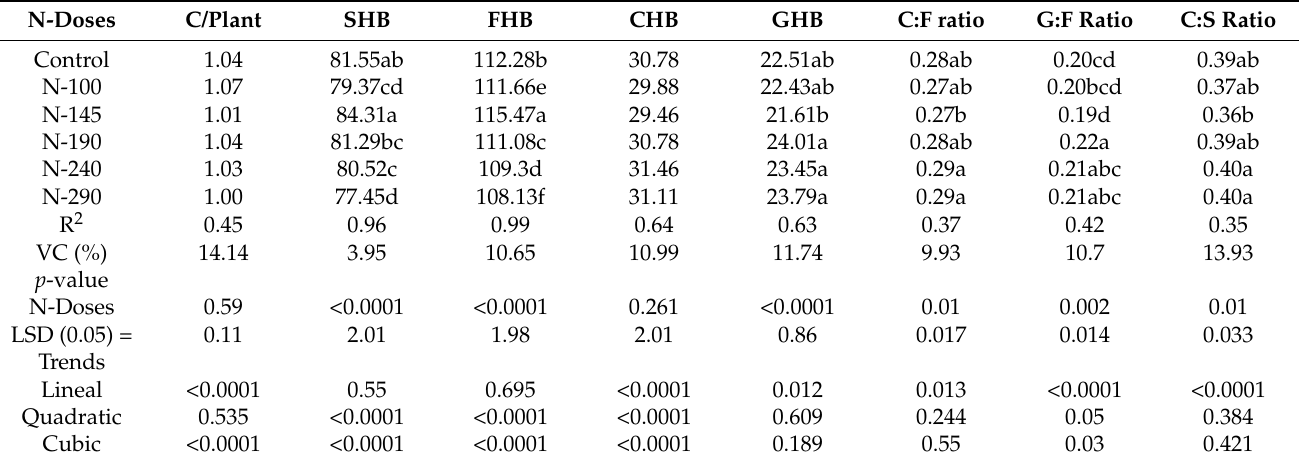
Table 3. Whole plant, cobs, and grain humid base (HB) yields